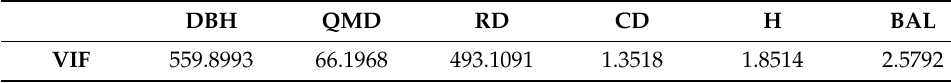
Table 3. Variance influence factor (VIF) of the predictor variables evaluated.